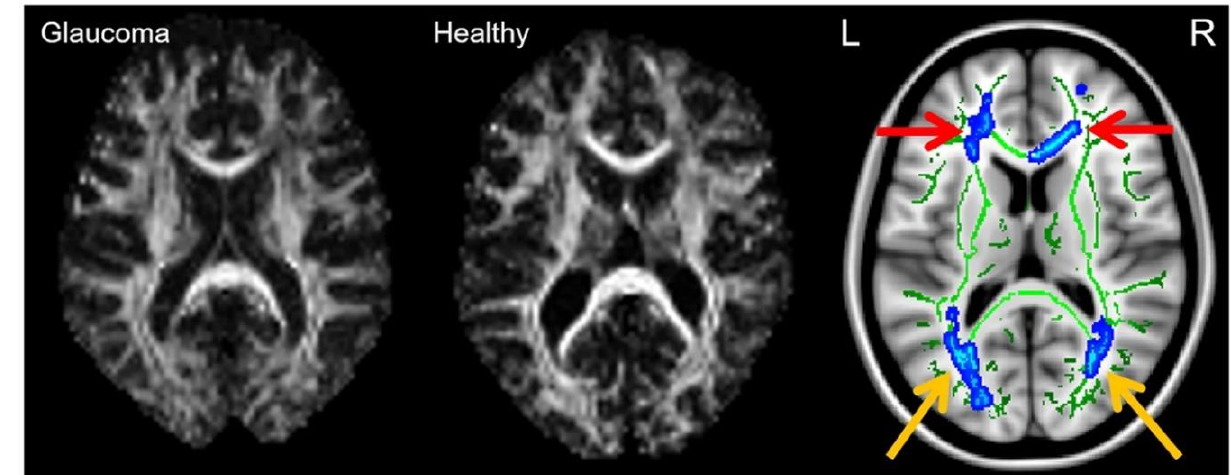
Figure 7. Fractional anisotropy (FA) maps at the level of the optic radiations in glaucoma ( left ) and healthy control subjects ( middle ). ( Right ) Colored maps of group comparisons, estimated with tract-based spatial statistics (TBSS), are overlaid on a standard MNI152 T1 MRI template. Green pixels correspond to the white matter tracts skeleton, and blue pixels correspond to brain regions of reduced FA in advanced glaucoma compared to early glaucoma at the optic radiations (yellow arrows) and frontal lobe white matter (red arrows). Images are reproduced from Murphy et al. [94].